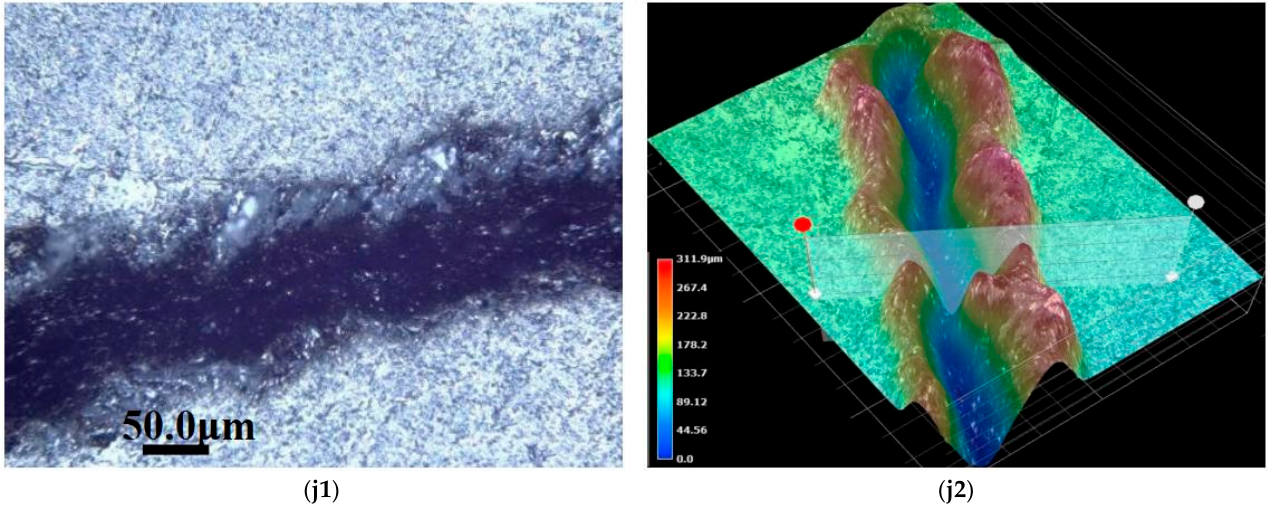
Figure 3. Laser confocal microscope real-time view and 3D view of the sample: ( a ) 5 W; ( b ) 10 W; ( c ) 15 W; ( d ) 20 W; ( e ) 25 W; ( f ) 30 W; ( g ) 35 W; ( h ) 40 W; ( i ) 45 W; ( j ) 50 W.